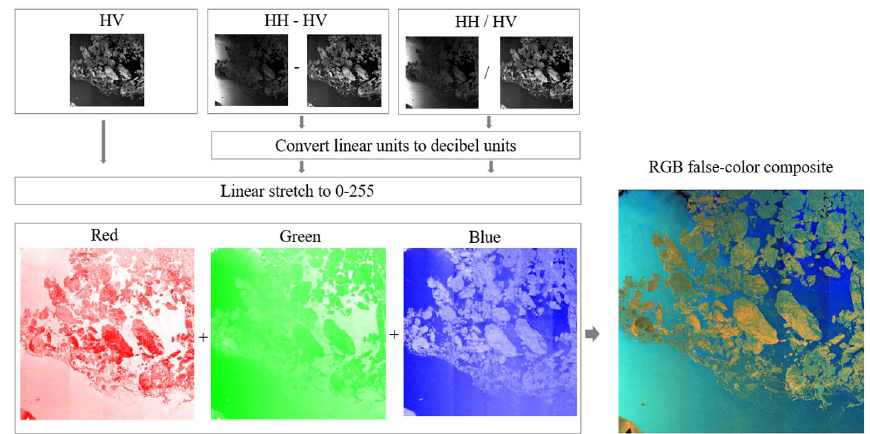
Figure 5. Illustration of combining HV-polarized data with polarization ratio and polarization difference data into an RGB false-color composite, which presents more textures and details than either HV- or HH-polarized